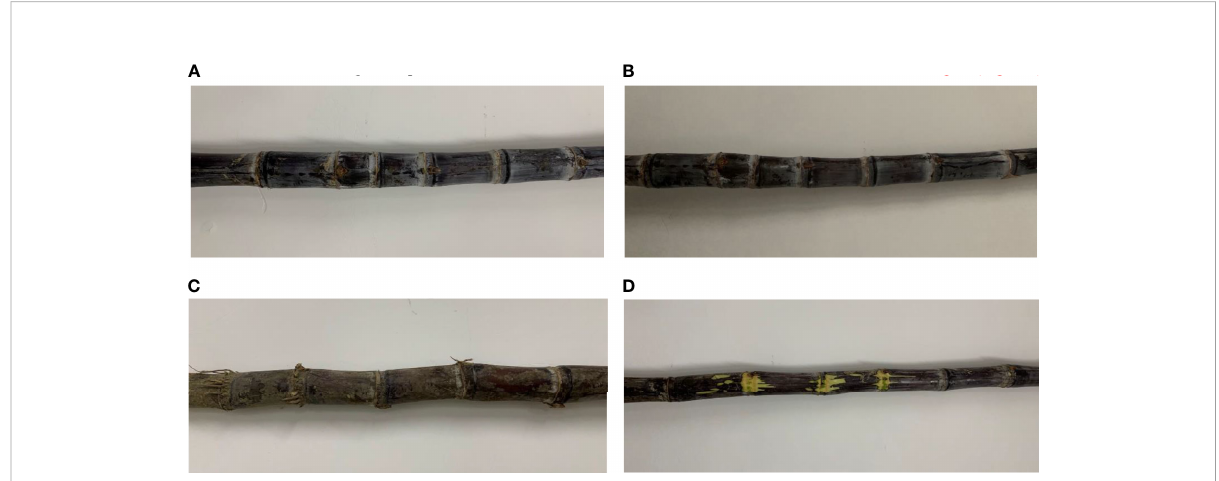
FIGURE 5 Sugarcane samples. (A) Images captured with normal lighting (B) Images taken under dark light (C) Image of sugarcane with dirt (D) Image of stem node damage.